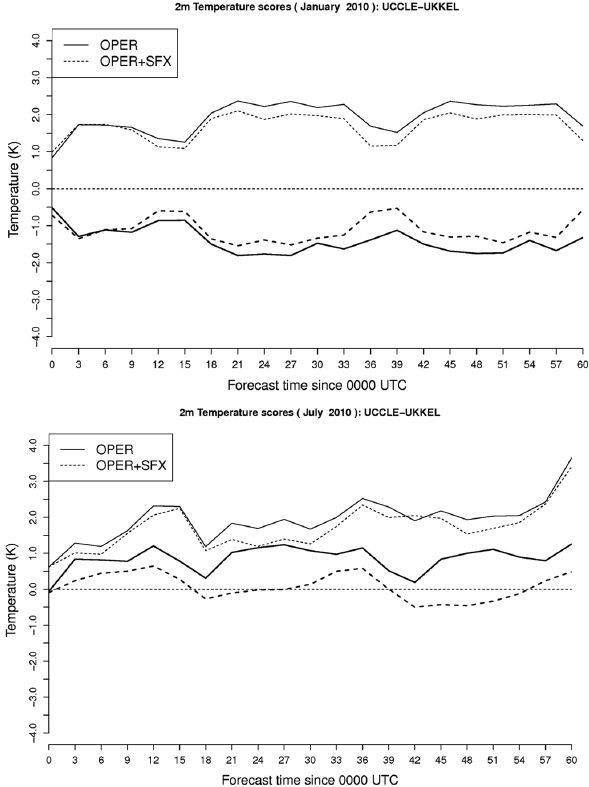
Fig. 2. Statistical scores of 2m temperature against observations at the suburban Uccle station (bias: thick line; rmse: thin lines) for Jan- uary (top) and July (bottom) for ALARO without SURFEX (OPER, solid lines) and with SURFEX (OPER+SFX, dashed lines) simu-